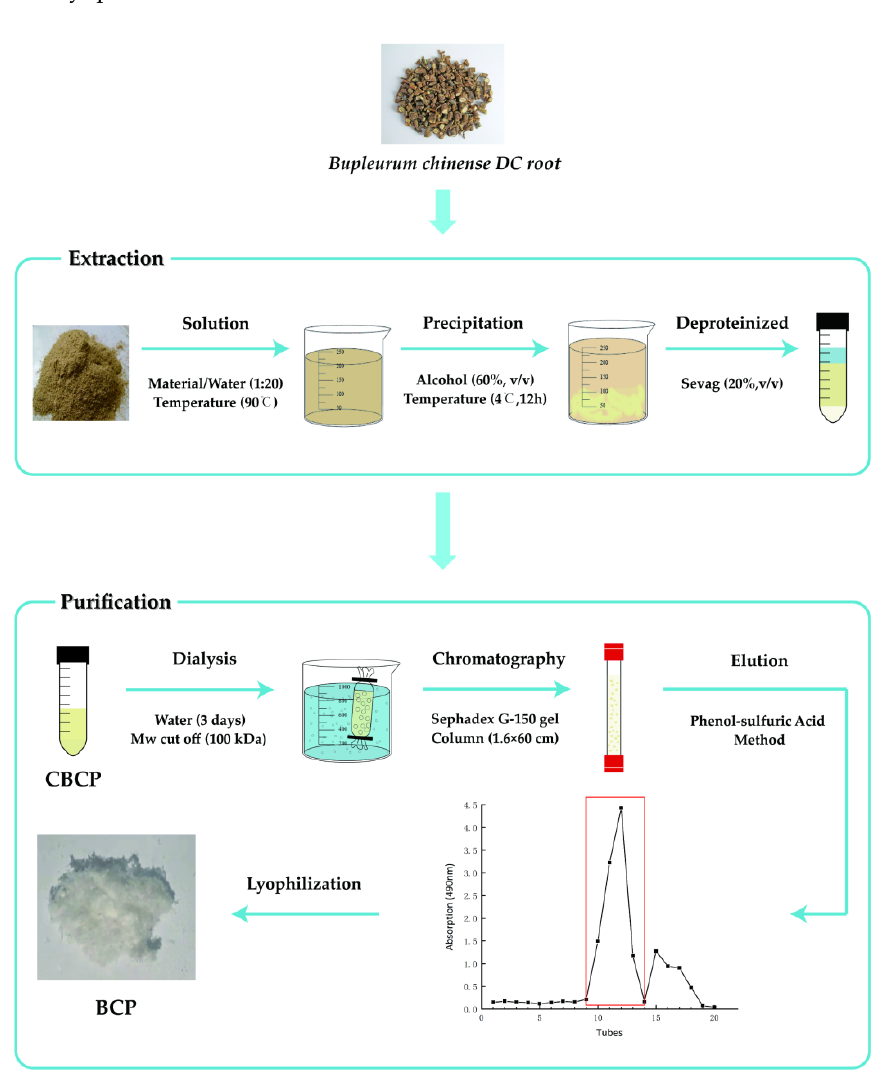
Figure 1. The preparation process diagram of BCP.